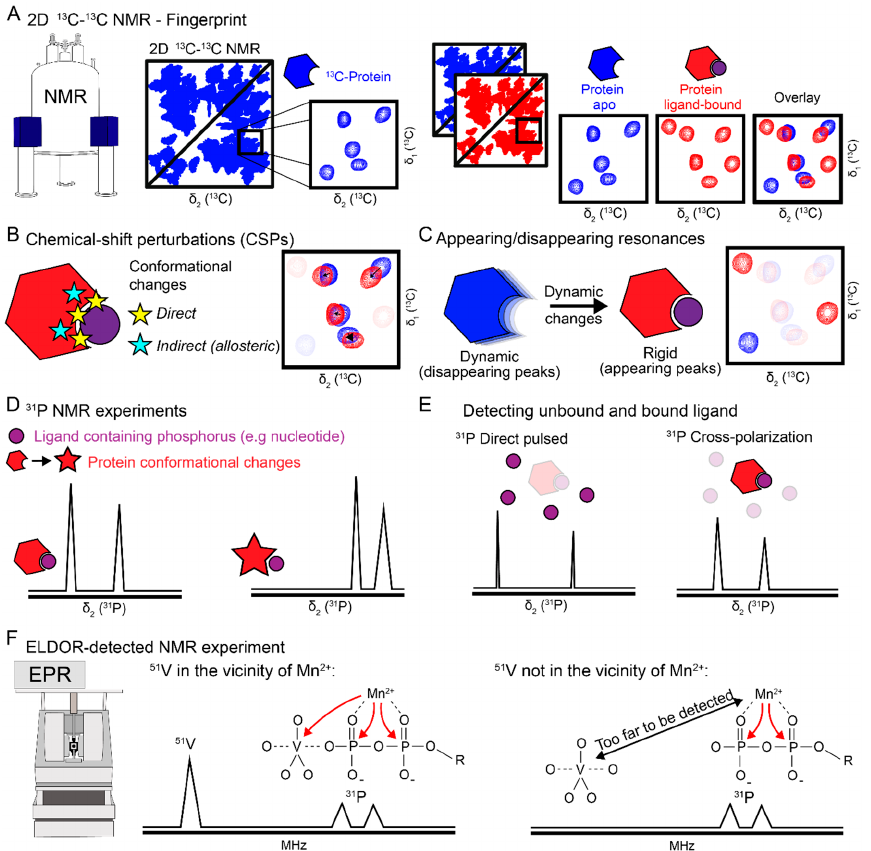
Figure 1. Magnetic-resonance approaches used to investigate the helicase DnaB and the ABC transporter BmrA in presence of ATP mimics. The employed techniques comprise 2D 13 C- 13 C NMR spectral fingerprints ( A ), 13 C chemical-shifts perturbations ( B ), appearing/disappearing resonances due to dynamic changes ( C ), 31 P NMR experiments (D ) to detect bound and unbound ligands ( E ) and ELDOR-detected NMR experiments ( F ), Details are given in the text.